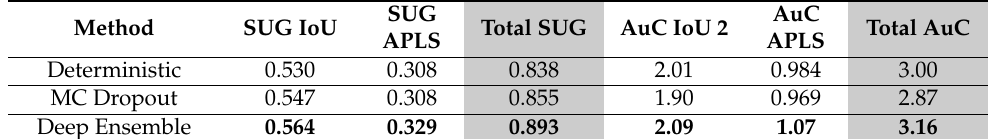
Table 3. Summary of results of model performance in OOD data at varying amounts of thresholding for quality assessment.